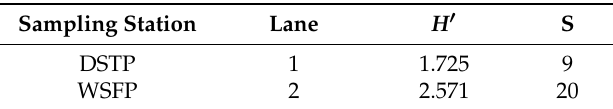
Table 2. Genetic biodiversity of Lake Wilson at two sampling stations downstream of the sewage treatment plant (DSTP) and Wahiawa State Freshwater Park (WSFP) calculated with denaturing gradient gel electrophoresis (DGGE) banding data and DNA fragment. Sampling